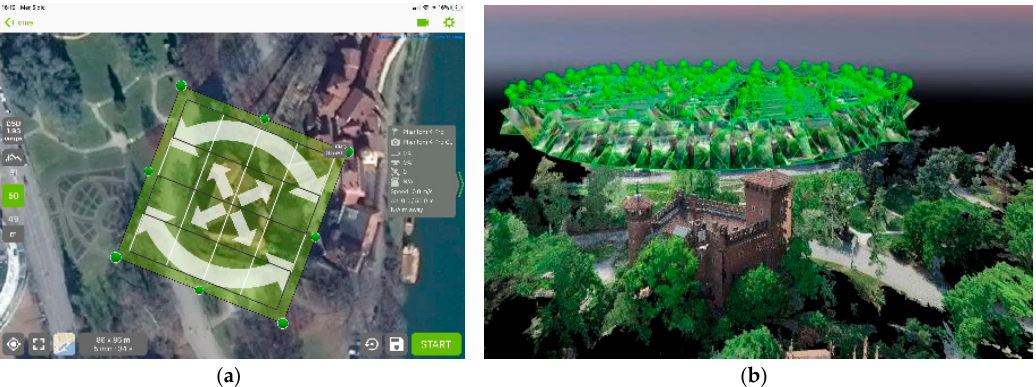
Figure 6. ( a ) The flights performed by Phantom 4 PRO ( b ) oriented UAV images block on the Rocca.